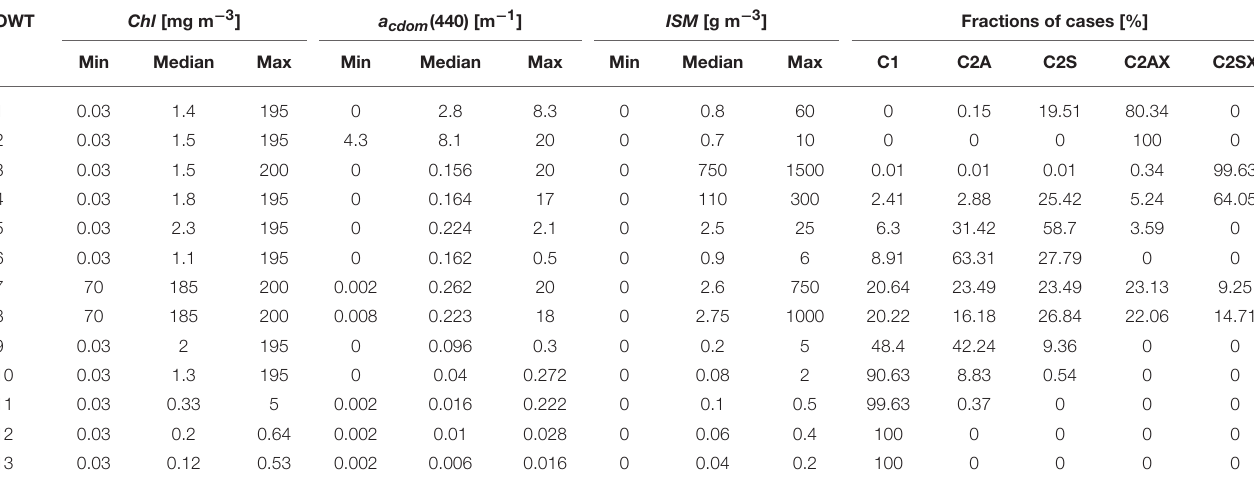
TABLE 2 | Chlorophyll, CDOM, and inorganic suspended matter concentrations for the 13 optical water types.